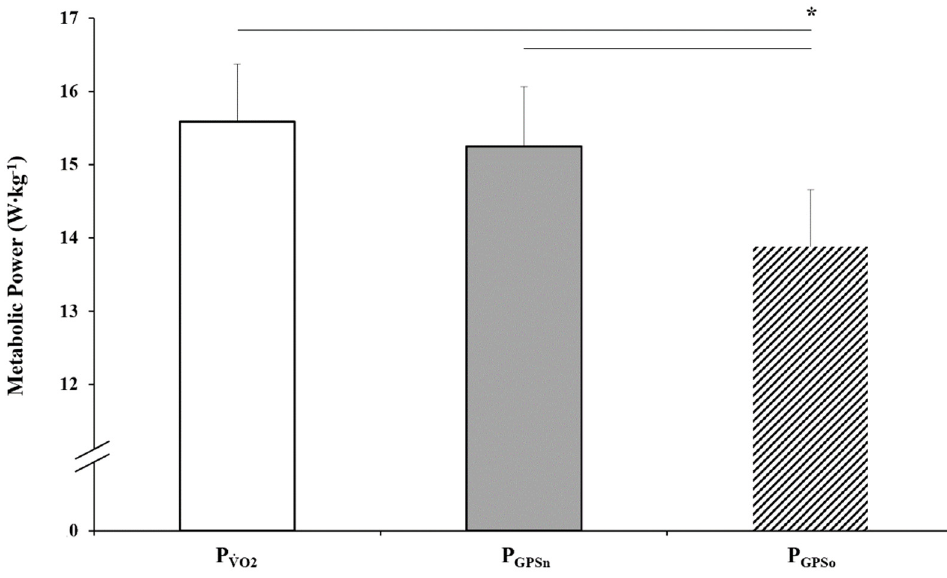
Figure 6. Metabolic power derived from direct measurement ( P (cid:2906)(cid:4662)(cid:2899) . two energy cost equations (P GPSn and P GPSo ). Statistical significance is denoted as “*”, p < 0.001, over MP conditions.